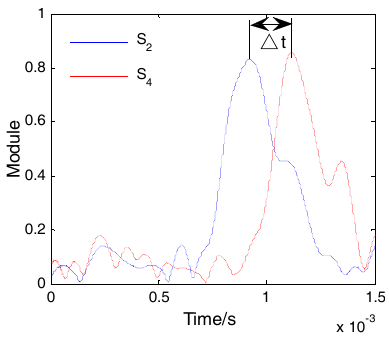
Figure 6. Time difference between S 2 and S 4 .